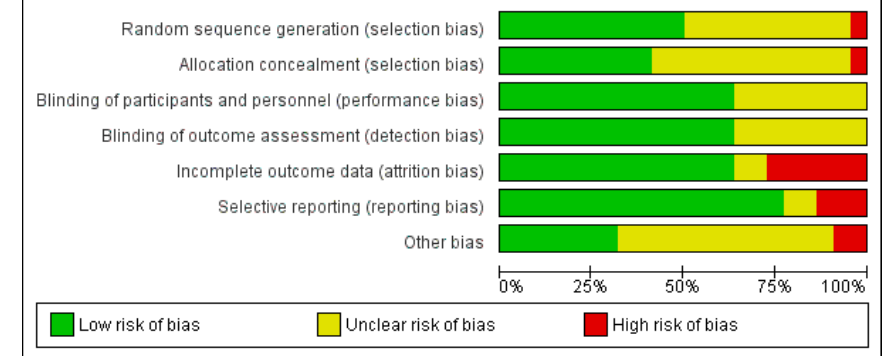
Figure A17. Risk of bias in human studies. Risk of bias assessment in human studies appeared to be very unclear for most items.